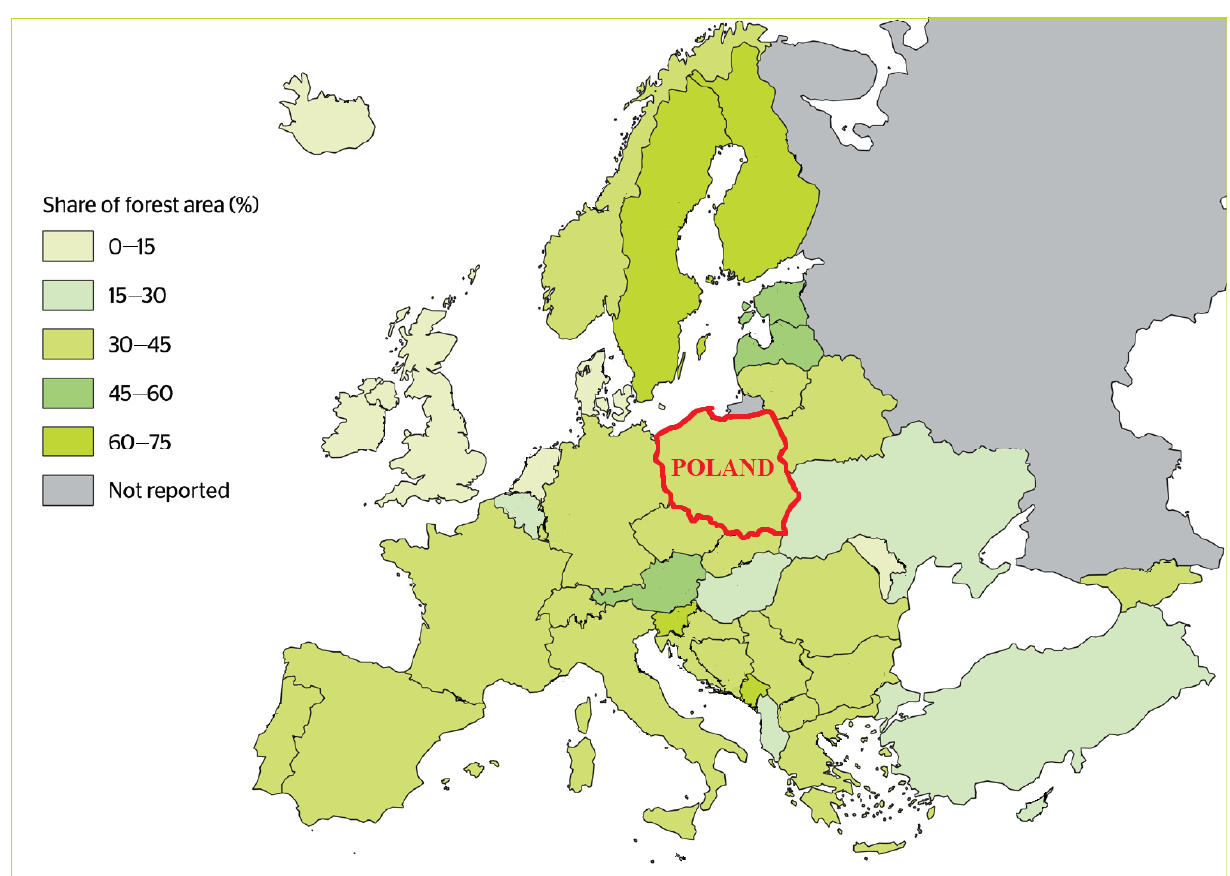
Figure 1. Poland’s forest area as compared to other countries of Europe (source: [1],